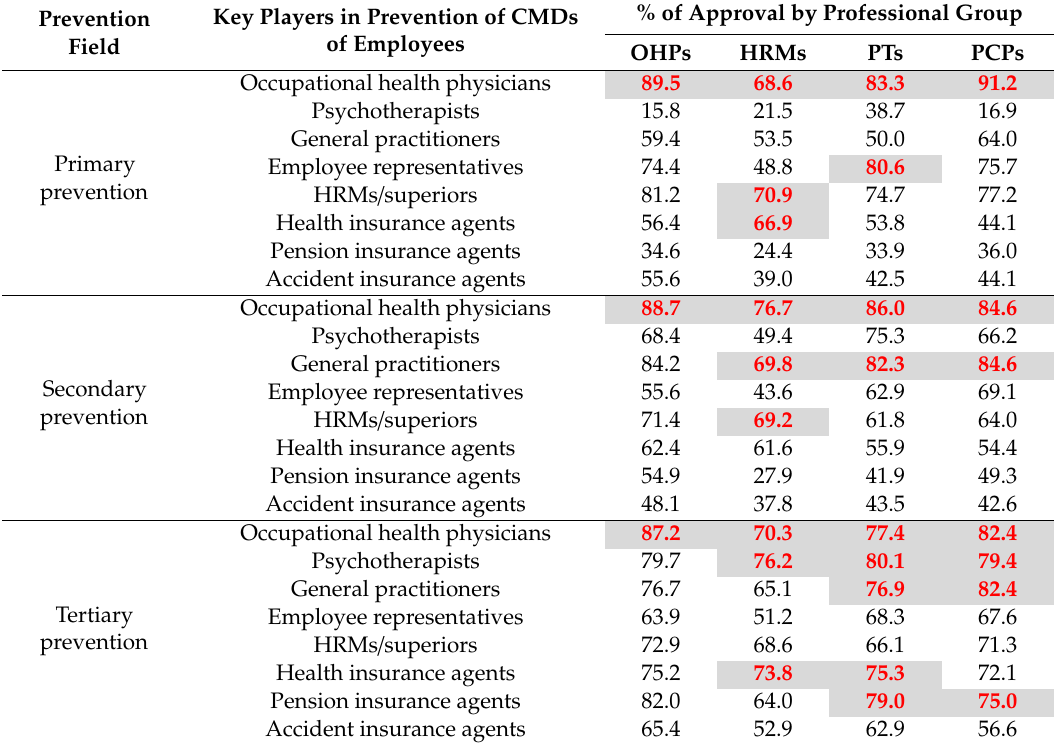
Table 2. Who should play a key role in the prevention of common mental disorders in employees? Perceptions of four professional